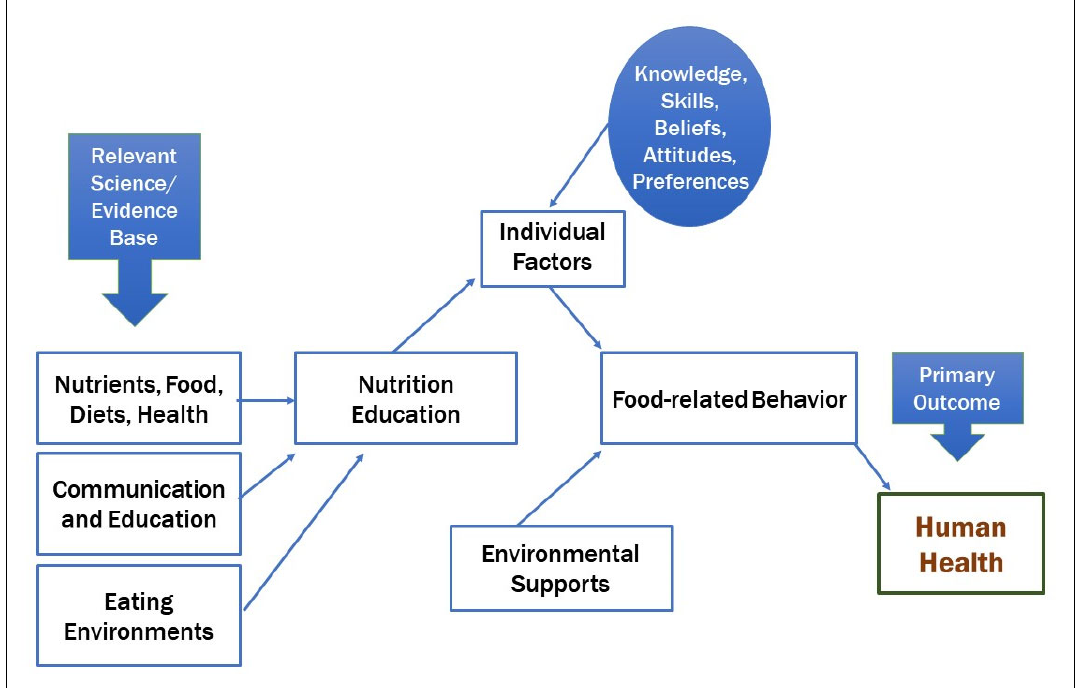
Figure 3. Traditional Model of Nutrition Education focused on Human Health